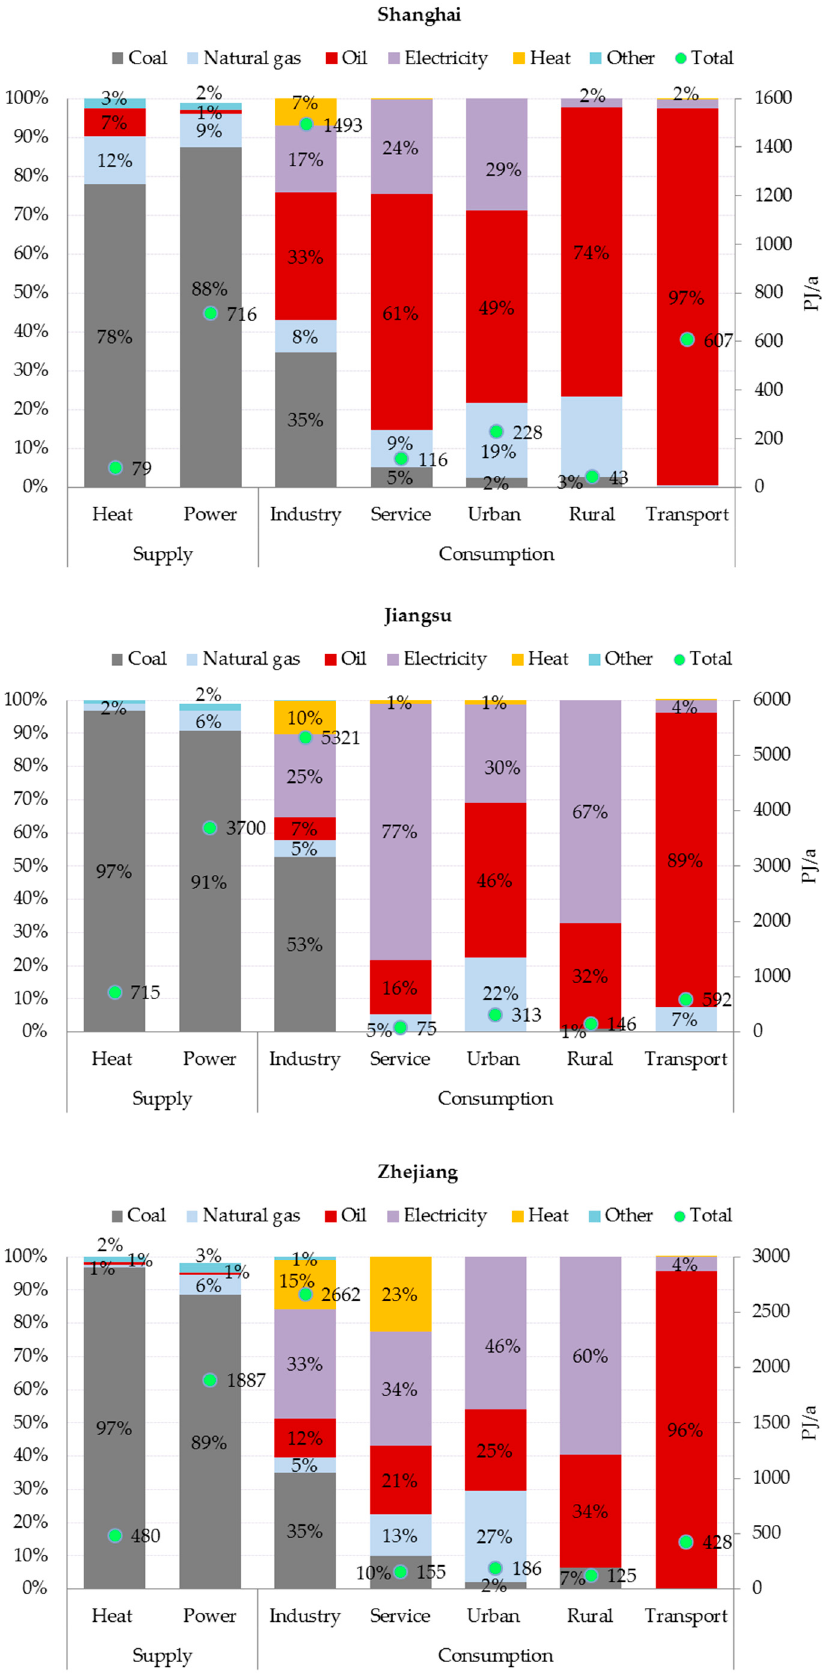
Figure A2. Heat and power energy supply and final energy consumption in YRD region in 2015 by sector [17].